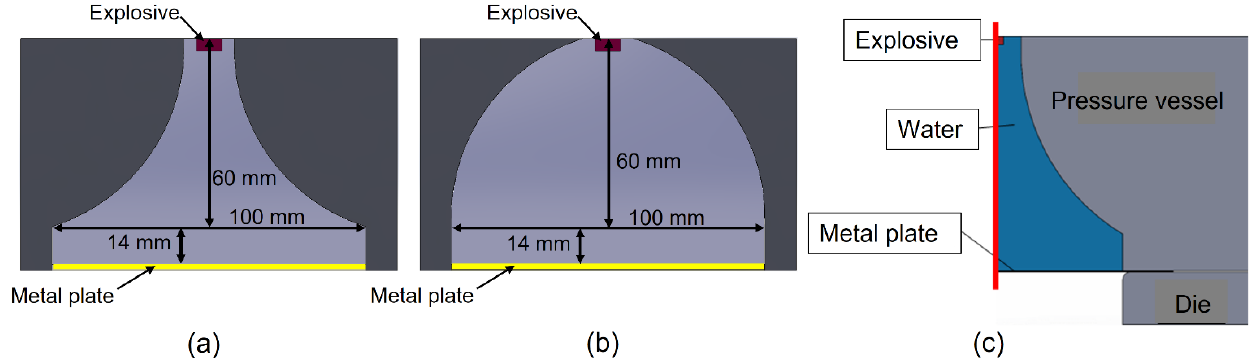
Figure 4. Numerical simulation models. ( a ) Hyperbolic pressure vessel. ( b ) Parabolic pressure vessel. ( c ) Overview of analysis target.